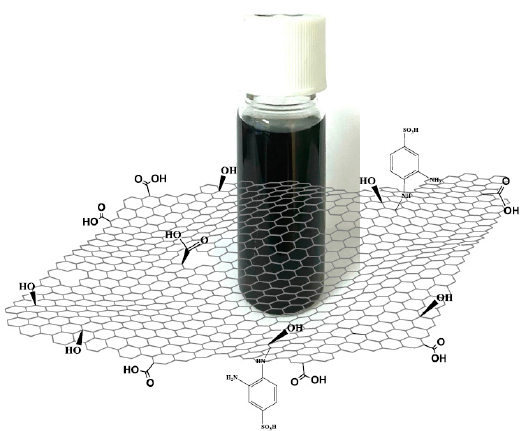
Figure 1. Schematic representation of the f ‐ rGO ink.